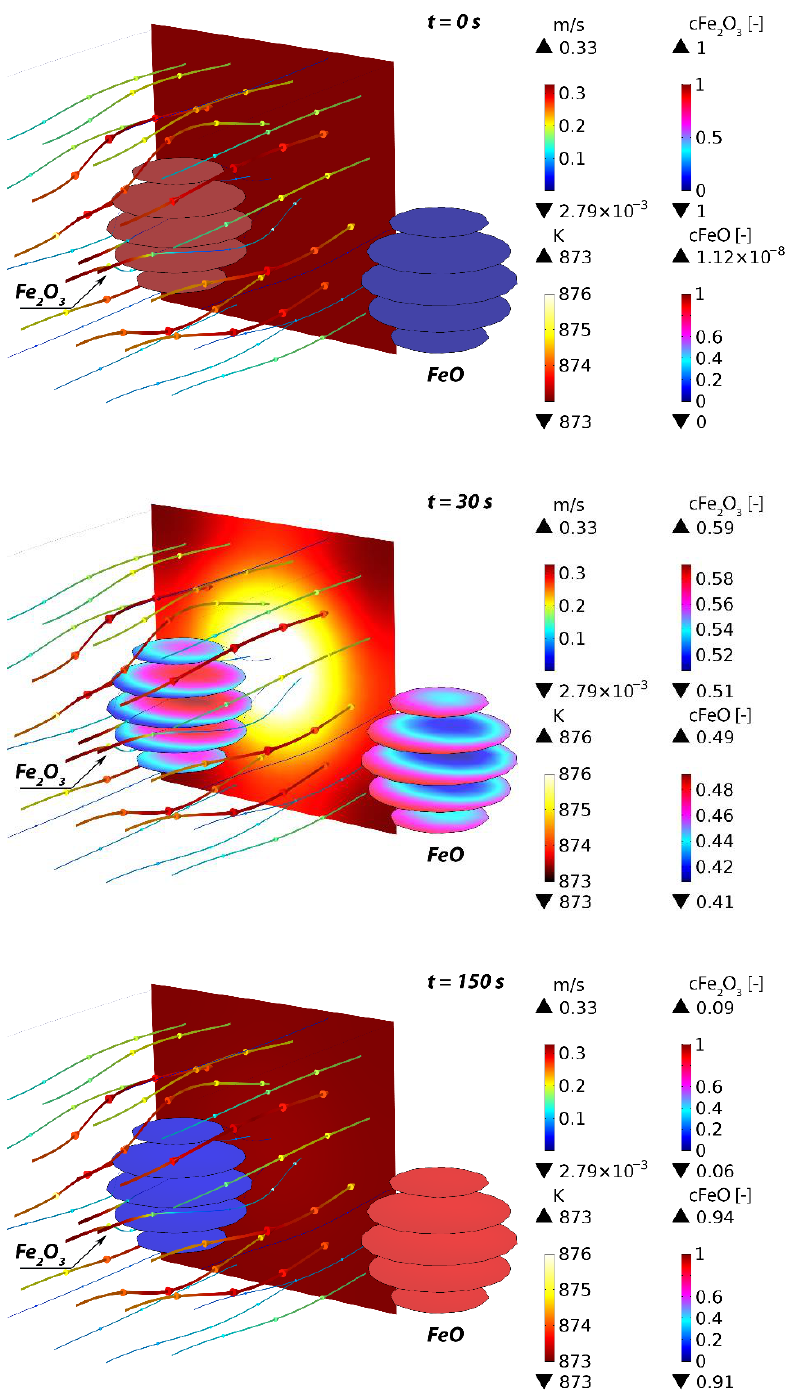
Figure 17. Change in OC concentration predicted by the 3D particle model at 0 s ( top ), 30 s ( middle ), and 150 s ( bottom ). and 150 s ( bottom